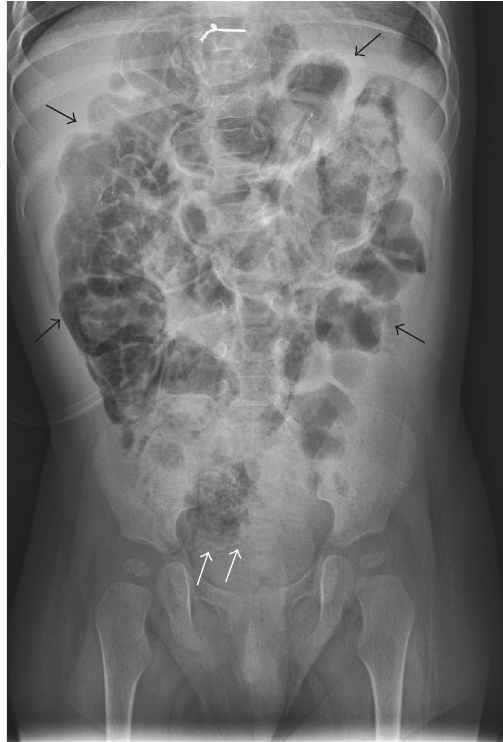
Figure 1: Abdominal X-ray (KUB) showing pneumatosis intesti- nalis, as evidenced by linear lucencies in the cecum (white arrows) and diffusely edematous bowel (black